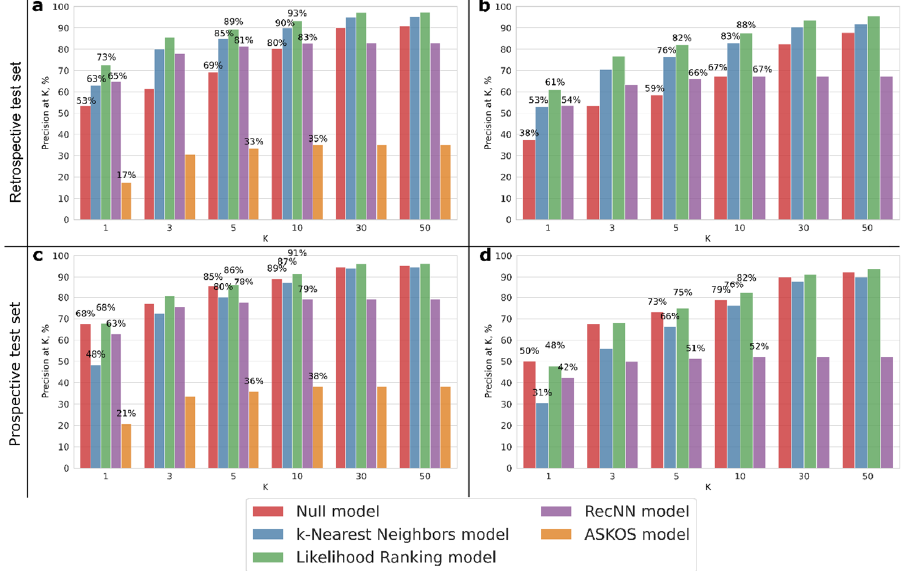
Figure 1. Cumulative histogram of the P@K on test sets vs. K; ( a , b )—retrospective test set, ( c , d )—prospective test set; ( a , c )—pressure is ignored.